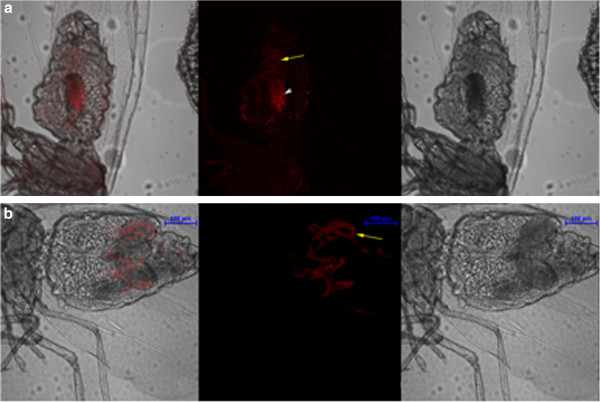
 FISH staining of Arsenophonus 16 S rRNA in whole mount of whitefly Bemisia tabaci . (A.b) DNA probe stains Arsenophonus in the bacteriocytes; (B.b) at the same concentration (1.0 pmoles) LNA probe shows higher signal and a low background while staining for Arsenophonus. Arrows indicate the bacteriocytes. White arrowhead indicates the non-specific background in DNA samples. The images have been taken at best formamide concentration for Arsenophonus DNA (30%) and LNA (70%) probes separately. Both DNA and LNA panels also show merged and DIC images (as a and c respectively).